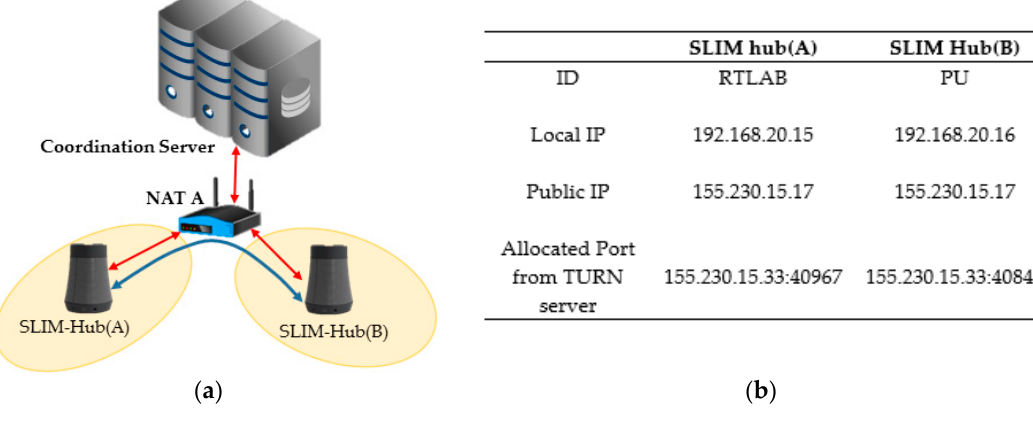
Figure 20. Connectivity checks in same private network. ( a ) ( b ) Figure 21. Connectivity environments of different NATs. ( a ) Configuration of experiments; ( b ) A list of SLIM hub’s ID and IP information.